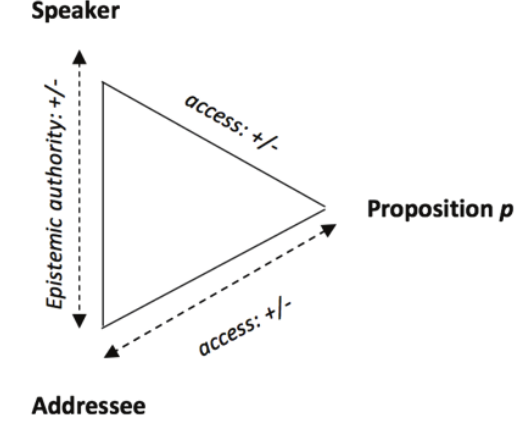
Figure 2: The stance triangle (after Du Bois 2007: 163) The functional motivation for engagement may be viewed as hinging on stance, given the role of (non-) alignment in both notions. This close connection between stance and engagement has also been noted in discourse studies by Hyland (2005) and others (e.g. White 2003). In this research tradition, stance is conceived of as reflecting the subjective positioning of the speaker, while engagement targets the speaker’s consideration of the addressee. Hyland (2005) lists “hedges” ( perhaps ) and “boosters” ( surely ) as devices for stance-taking and “appeals to shared knowledge” ( of course ) and “directives” ( consider x ) as devices that signal engagement (Hyland 2005: 178, 182). Even though Hyland discusses stance and engagement as separate concepts, the semantic overlap between devices used to signal both notions, suggest that stance and engagement cannot be kept separate. We may, in fact, illustrate engagement as stance using a modified version of Du Bois’ stance triangle (Figure 3, below). A similar graphic representation was originally used by Bergqvist (2018a) to account for egophoric marking in Ika (Chibchan, Colombia) and has natural applicability in the present discussion given the high degree of functional overlap between egophoric marking in Ika and engagement marking in Kogi (see Bergqvist 2018b, for a